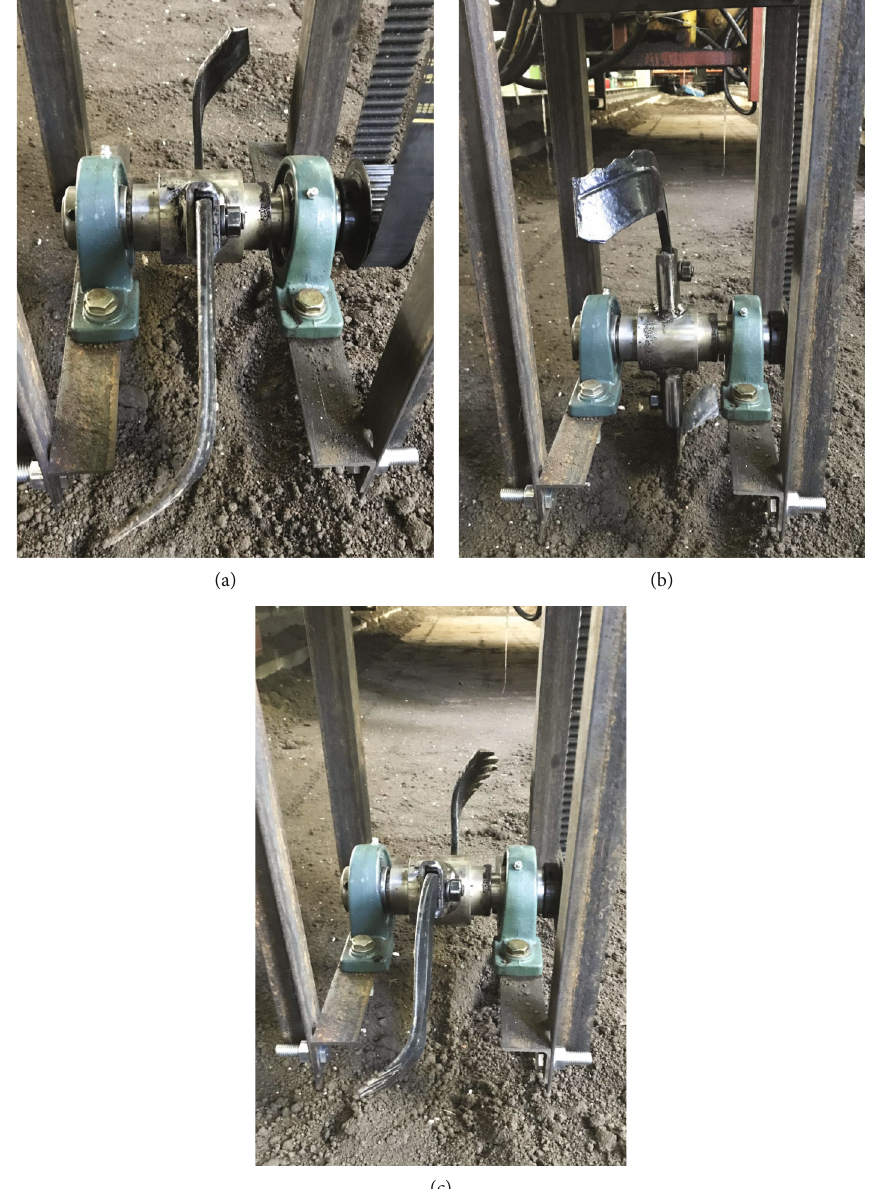
Figure 9: Three types of the blades used in the comparative test: (a) CB; (b) BB-2; (c)